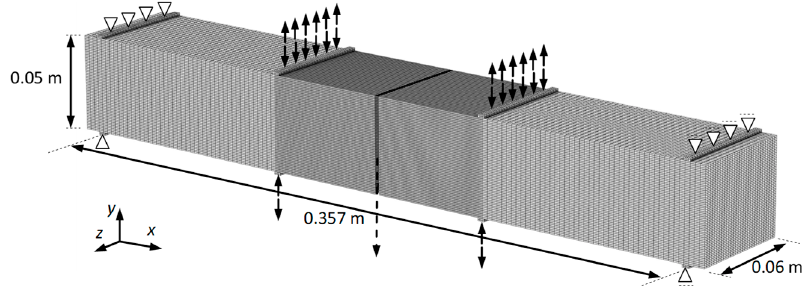
Figure 14. The relationship between the phase angle and temperature.